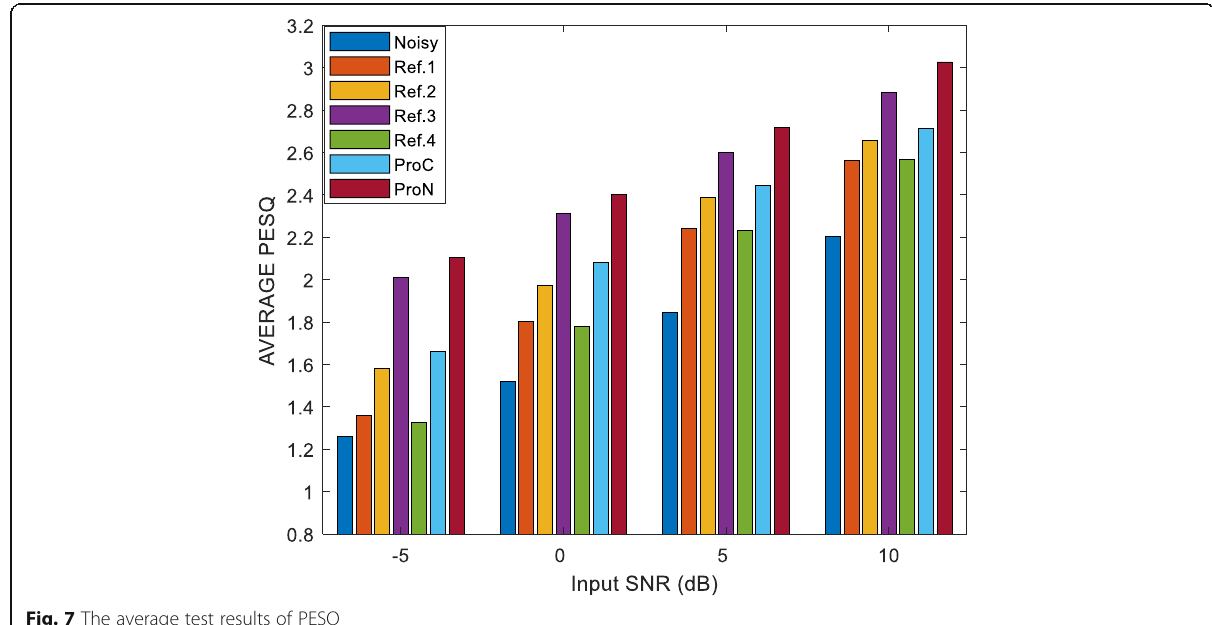
Fig. 7 The average test results of PESQ